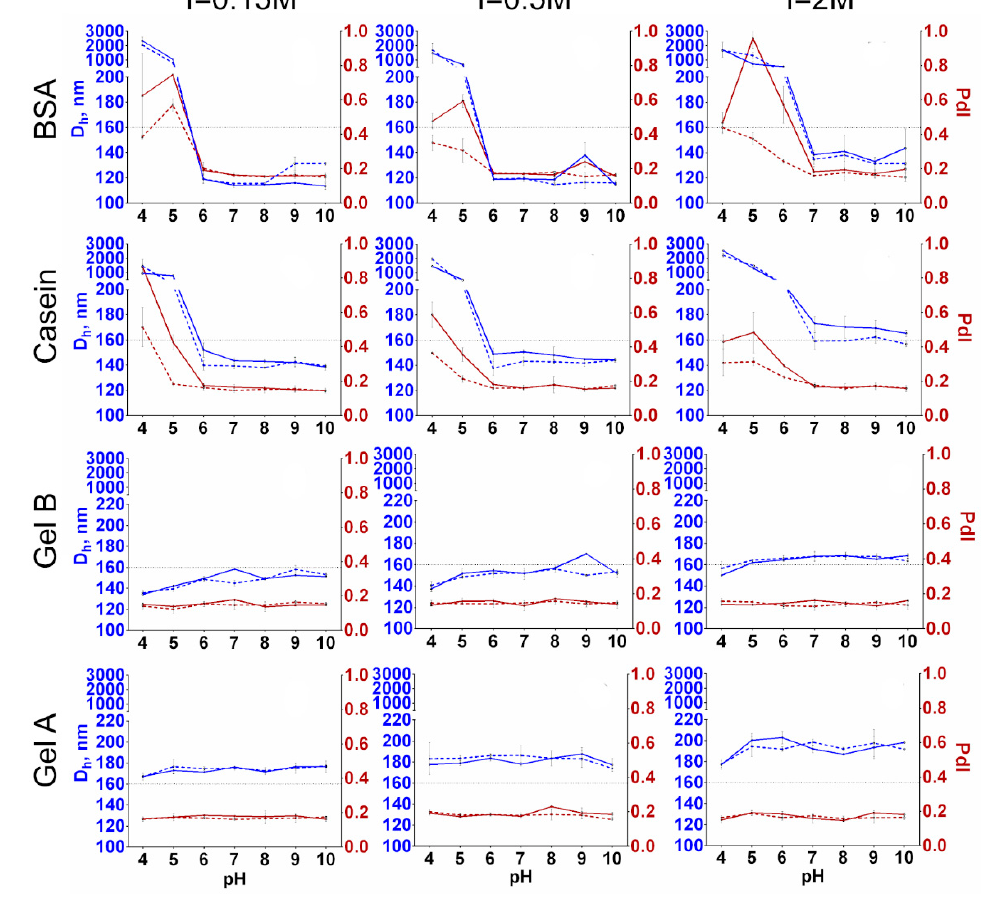
Figure 7. Colloidal stability of Fe@C-NH 2 /Protein/G in buffers with different pH and ionic strength values. Ionic strength values are specified at the top of the figure. “BSA”, “Casein”, “Gel B”, and “Gel A” indicate coating protein. Blue line—hydrodynamic diameter at 0 (dashed line) and 24 h (solid line); orange line—polydispersity index at 0 (dashed line) and 24 h (solid line), n = 3, mean ± SD.